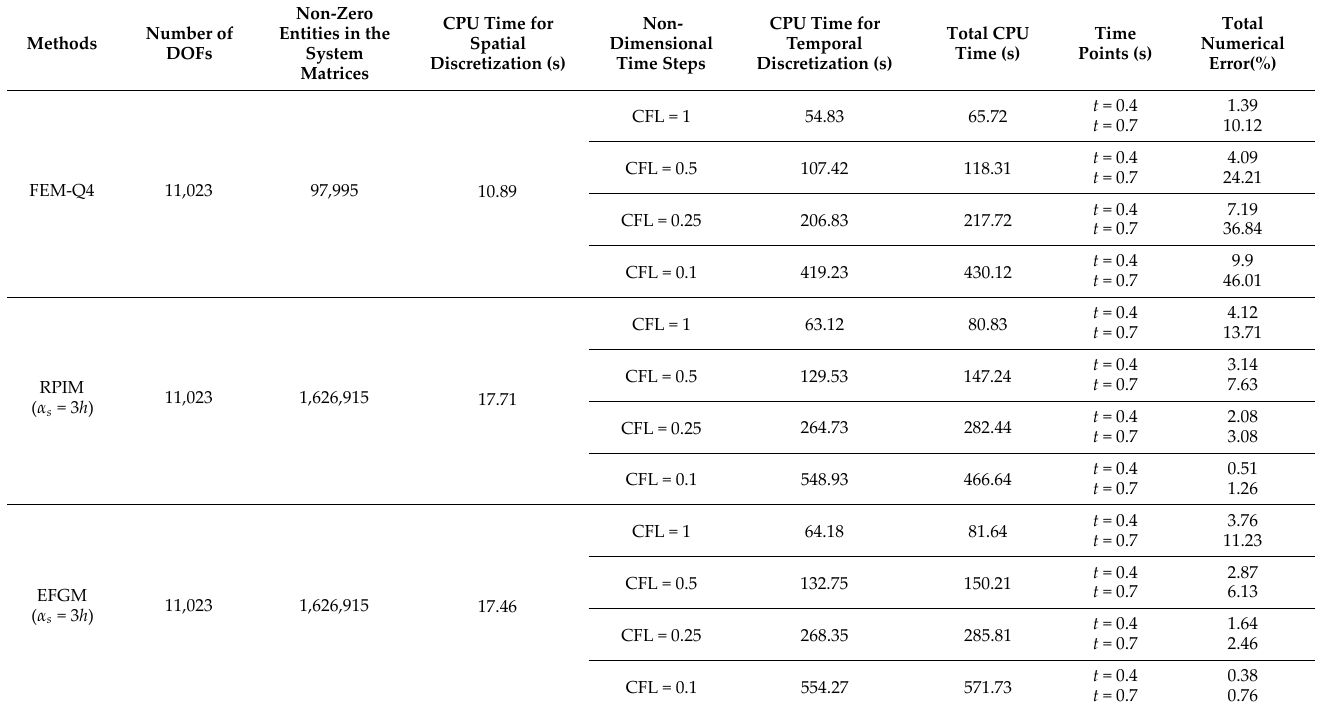
Table 2. The detailed computational cost of different numerical methods in solving the numerical experiment in Section